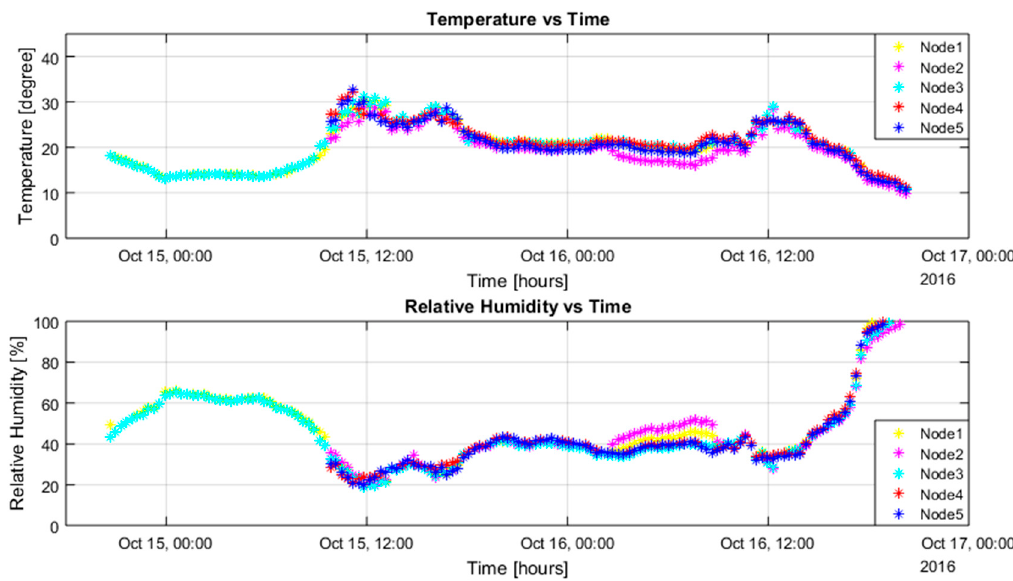
Figure 8. Supercapacitor-powered sensor nodes’ performance.